Question: What does this figure show? Answer in one sentence.
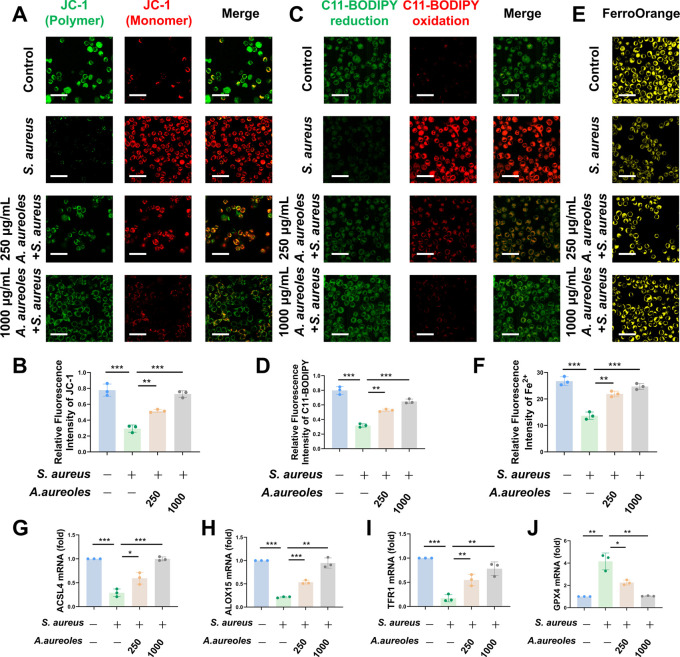
Answer: A. aureoles GGNSJ001 protects RAW 264.7 cells against S. aureus -triggered ferroptosis. RAW 264.7 cells were treated with S. aureus (MOI = 10) for the indicated time. A. aureoles GGNSJ001 was added to RAW 264.7 cell culture medium before and after S. aureus infection for the indicated time. JC-1 staining assessed membrane potential ( A and B ). Lipid peroxide production was assessed by BODIPY 581/591 C11 staining ( C and D ). Fe 2+ levels were assessed by FerroOrange staining. ( G–J ) The relative mRNA levels of ACSL4 ( G ), ALOX15 ( H ), TFR1 ( J ), and GPX4 ( J ) were assessed by q-RT-PCR ( E and F ). The error bars represent the standard error of the mean. * P < 0.05, ** P < 0.01, and *** P < 0.001. All data are representative of three independent biological experiments performed in triplicates.